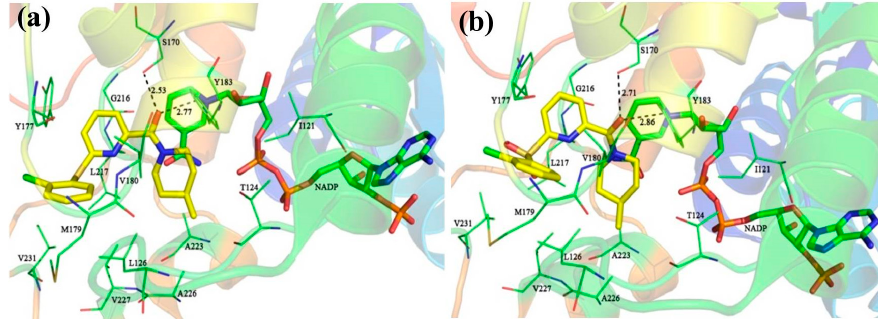
Figure 1. The detailed binding modes of complexes 11 β -HSD1- 11 ( a ) and 11 β -HSD1- 14 ( b ).